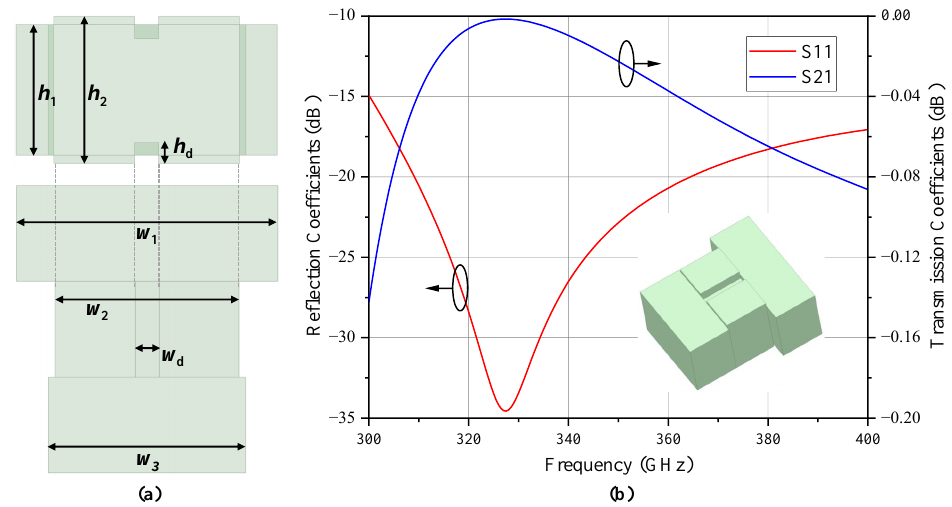
Figure 9. ( a ) The configuration of the transition between nonstandard and standard waveguide. ( b ) The S-parameters simulation results of the above waveguide transition. Based on the 2-way T-junction power divider, the 90 ◦ E-plane waveguide bend and the transitions, a 16-way power divider was designed. The 16 output ports are arranged at equal intervals (2 mm). Figure 10 shows the simulated S-parameters of the power divider. It can be seen that S11 is better than − 10 dB in 300 GHz to 380 GHz, and the 16 outputs are in-phase and with same magnitude.